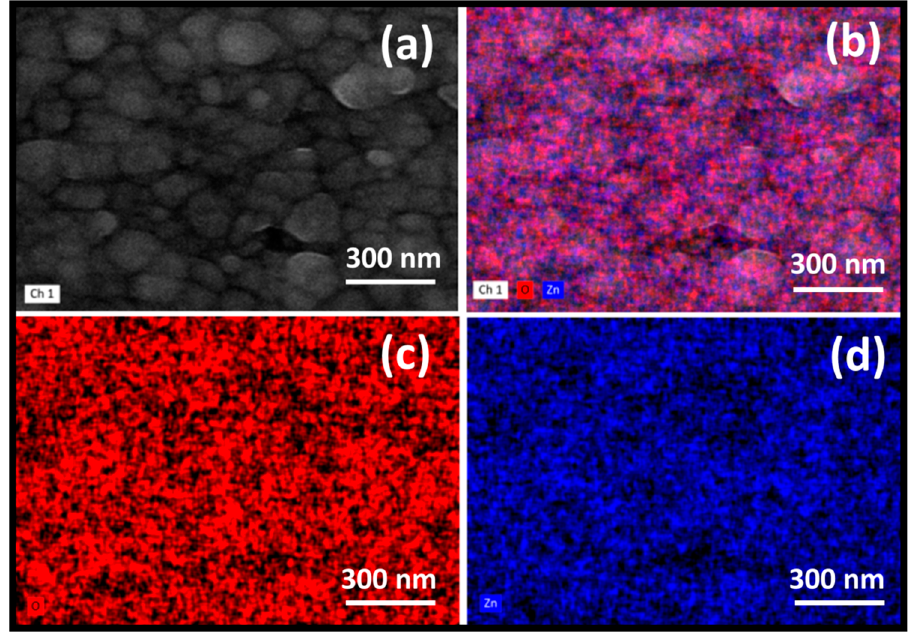
Figure 6. Elemental mapping analysis of a ZnO thin film: ( a ) specific area, ( b ) ZnO, ( c ) O and ( d ) Zn.